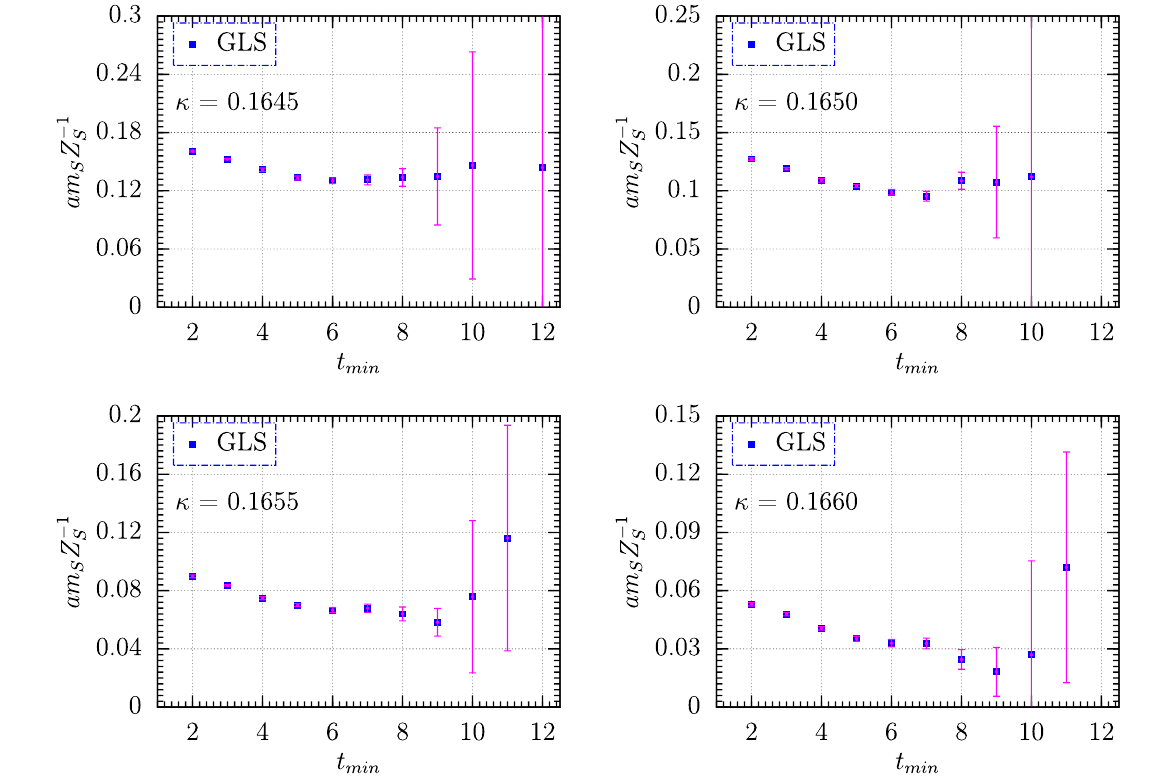
Fig. 1 The subtracted gluino mass am S Z − 1 as a function of t min calculated with the GLS Method at β = 5 . 6. At small values of t min the subtracted S gluino mass is affected by contact terms and by O ( a ) terms. Data from t min = 2 and t min = 3 are shown, but do not enter our final analysis